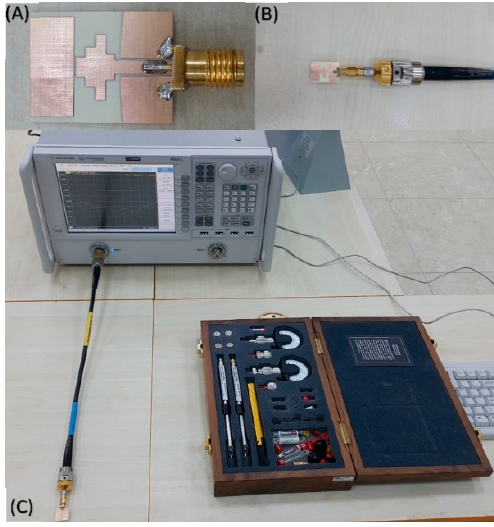
Figure 3. Photograph of the fabricated CPW-fed monopole antenna; ( A ) front view; ( B ) connecting to VNA; and ( C ) experimental set up to measure return loss.